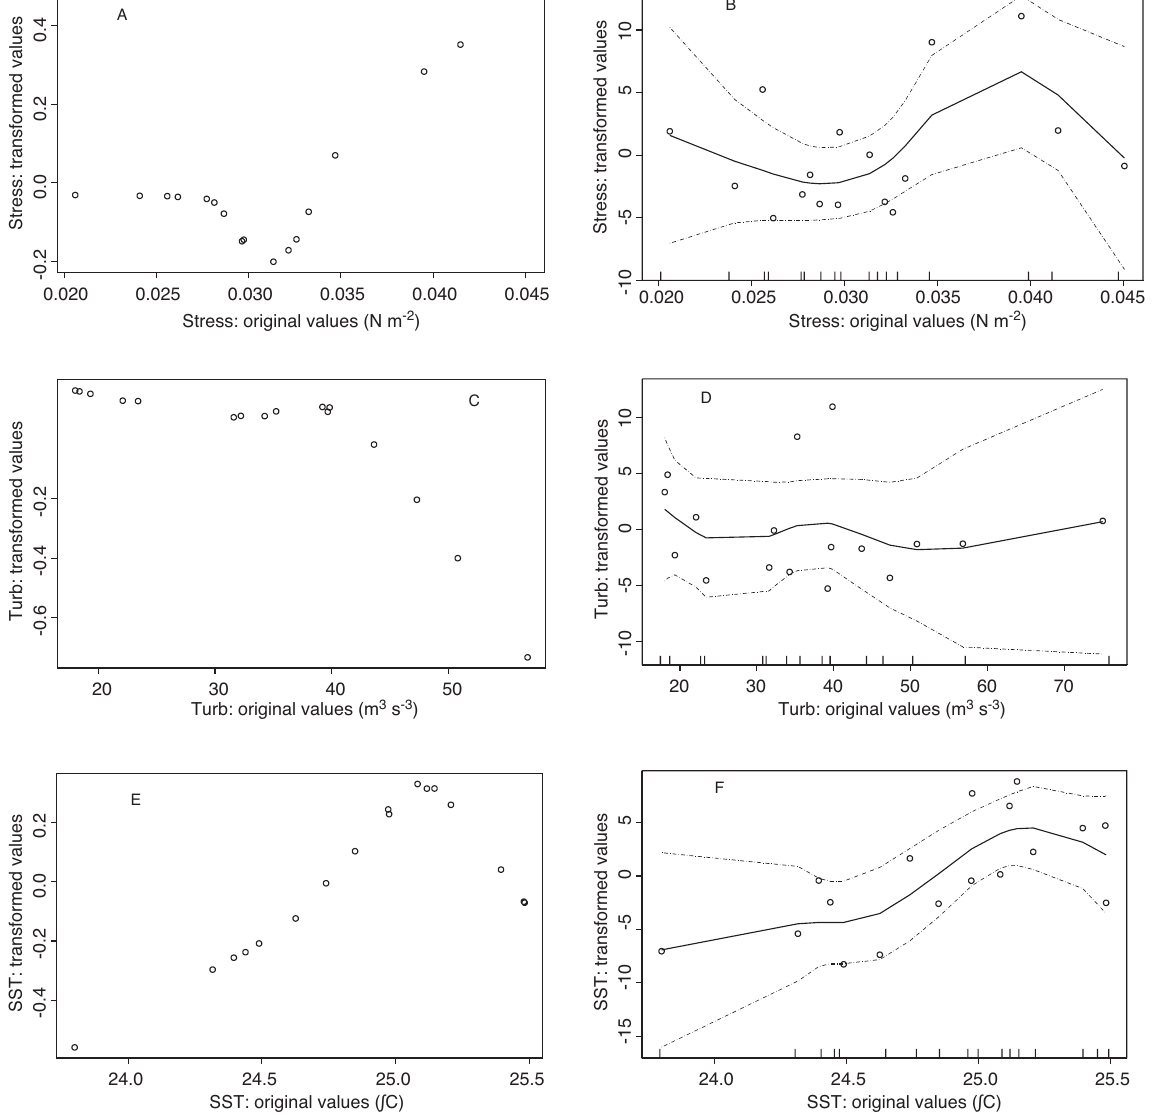
F IG . 8. – ACE transformations for (A) wind stress, (C) turbulence index, without the point for 1990), and (E) SST in combination with SSB. GAM transformations for the same variables (8B, 8D and 8F; points are the partial residual deviances and the dotted line 2 × s.e.). The form of the transformations is obtained by plotting the new transformed values of each variable against the original, observed